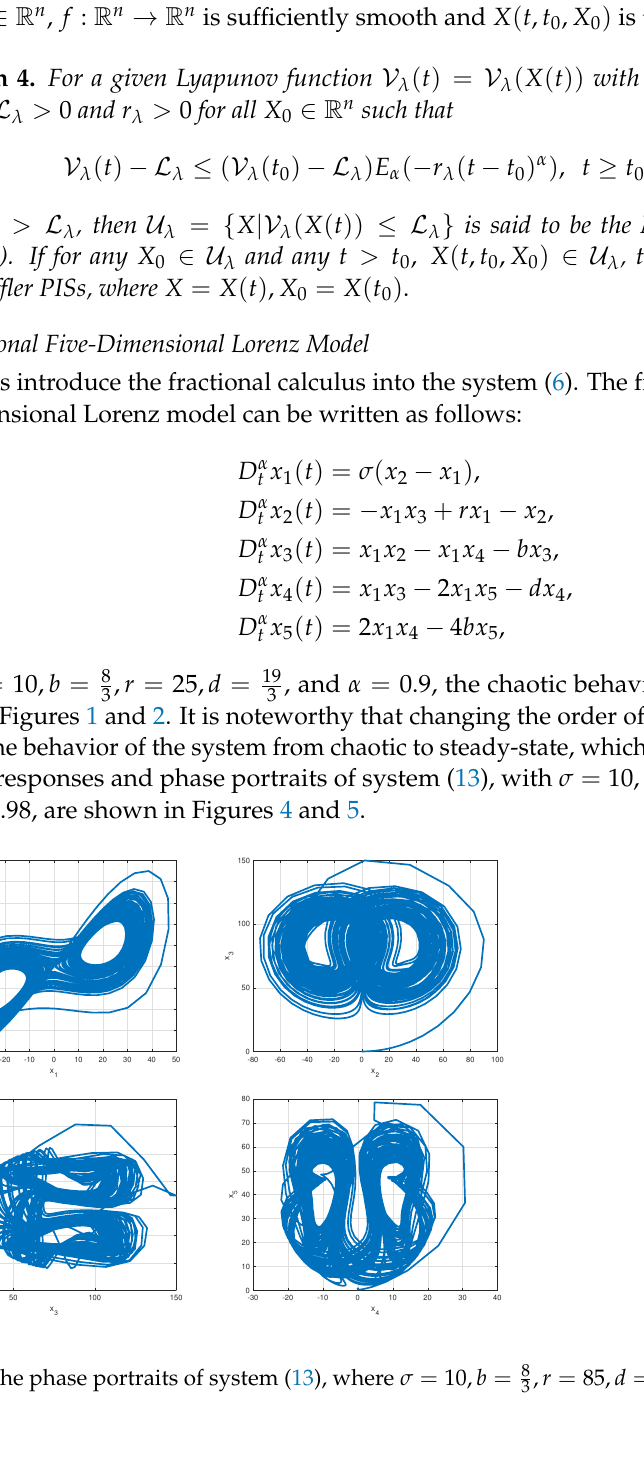
Figure 1. The phase portraits of system (13), where σ = 10, b = 8